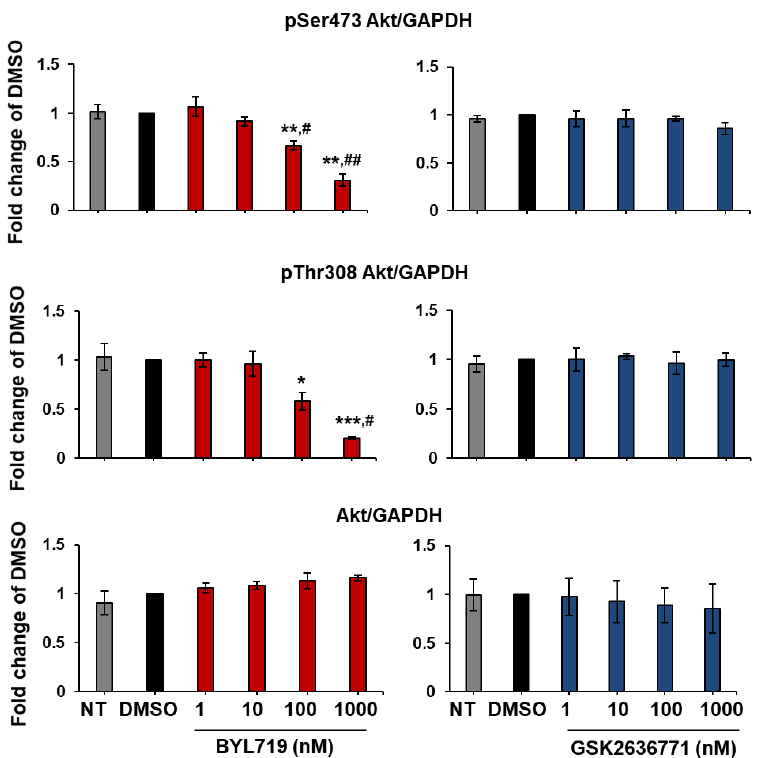
Figure 11. BYL719 inhibits Akt phosphorylation in Met1 cells in a dose-dependent manner. Met1 cells were treated with the indicated concentrations of BYL719 and GSK2636771 in complete medium supplemented with 10% FBS. Control cells were treated with DMSO or left untreated (NT). After 1 h, cells were Lysed and lysates were analyzed by Western blotting. GAPDH was used as loading control. Signals were visualized using Chemidoc™ MP Imaging System. Graphs indicate results from densitometry analysis of phosphorylated or total Akt normalized to loading control and expressed as fold change of results from DMSO-treated cells. Data are means ± SEM from n = 3 independent experiments (apart from data from cells treated with BYL719 1 nM, 10 nM and 100 nM, n = 4) * p < 0.05, ** p < 0.01, *** p < 0.001 vs. DMSO; # p < 0.05, ## p < 0.01 vs. NT.